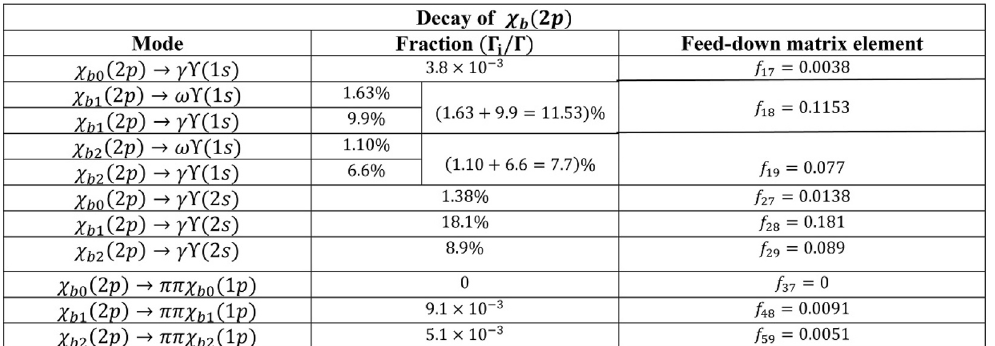
Table 2 . Decay modes of Υ(2 s ) , χ b (1 p ) , and Υ(3 s ) and the calculation of different elements of the feed-down matrix (5.2) using the experimentally measured branching ratios of the various bottomonium states [63].